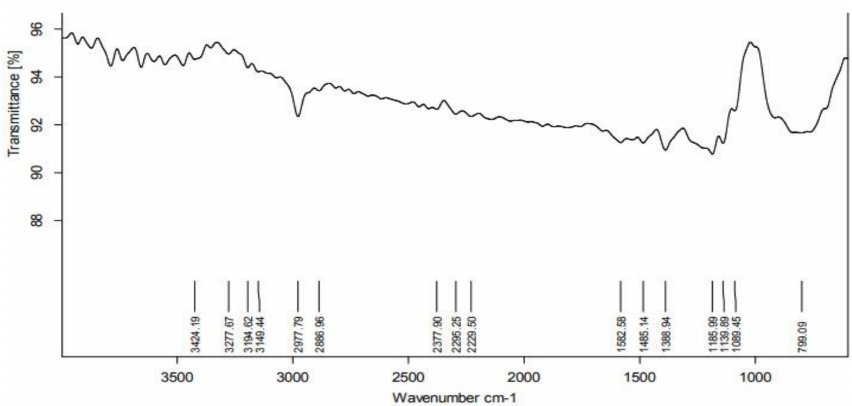
Figure 3. FTIR Spectra of Psidium guajava